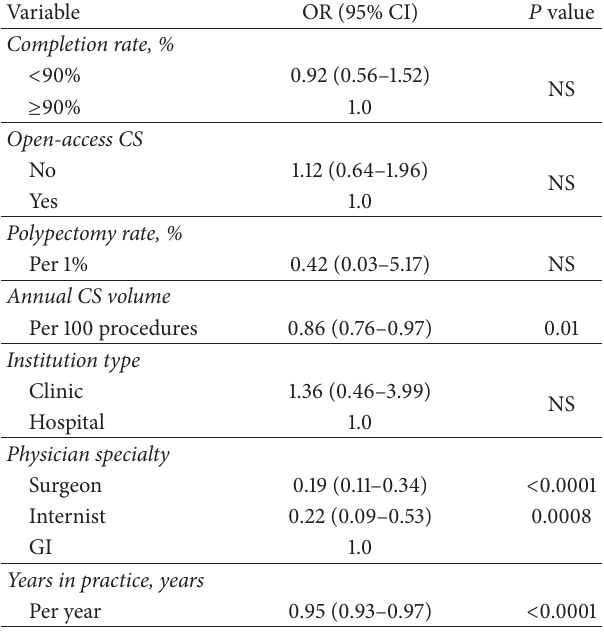
Table 3: Multivariable analysis on factors associated with good quality CS